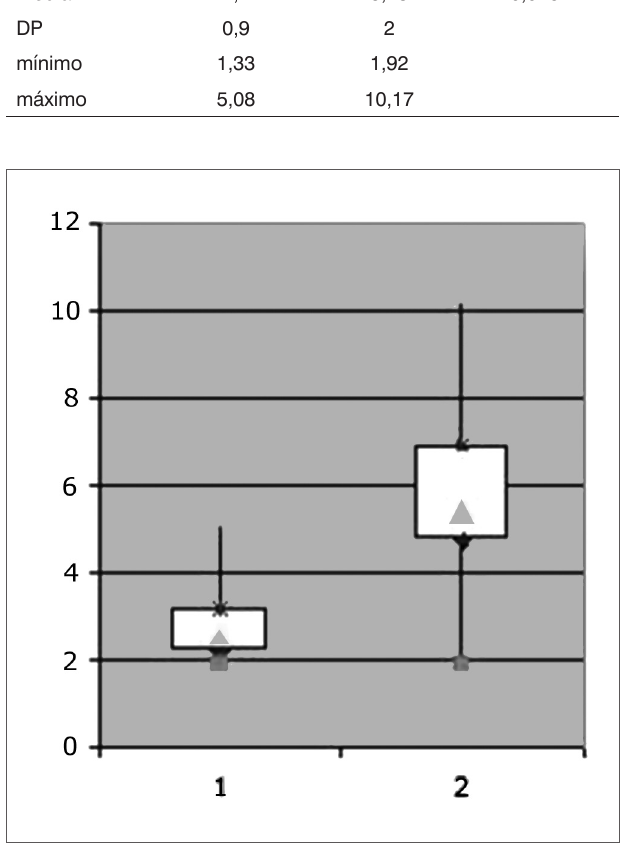
da saliva foram tabelados e o teste colorimétrico demons- trou que 45% da amostra diminuiu o potencial à cárie den- tária, 40% permaneceu inalterado, e apenas 15%